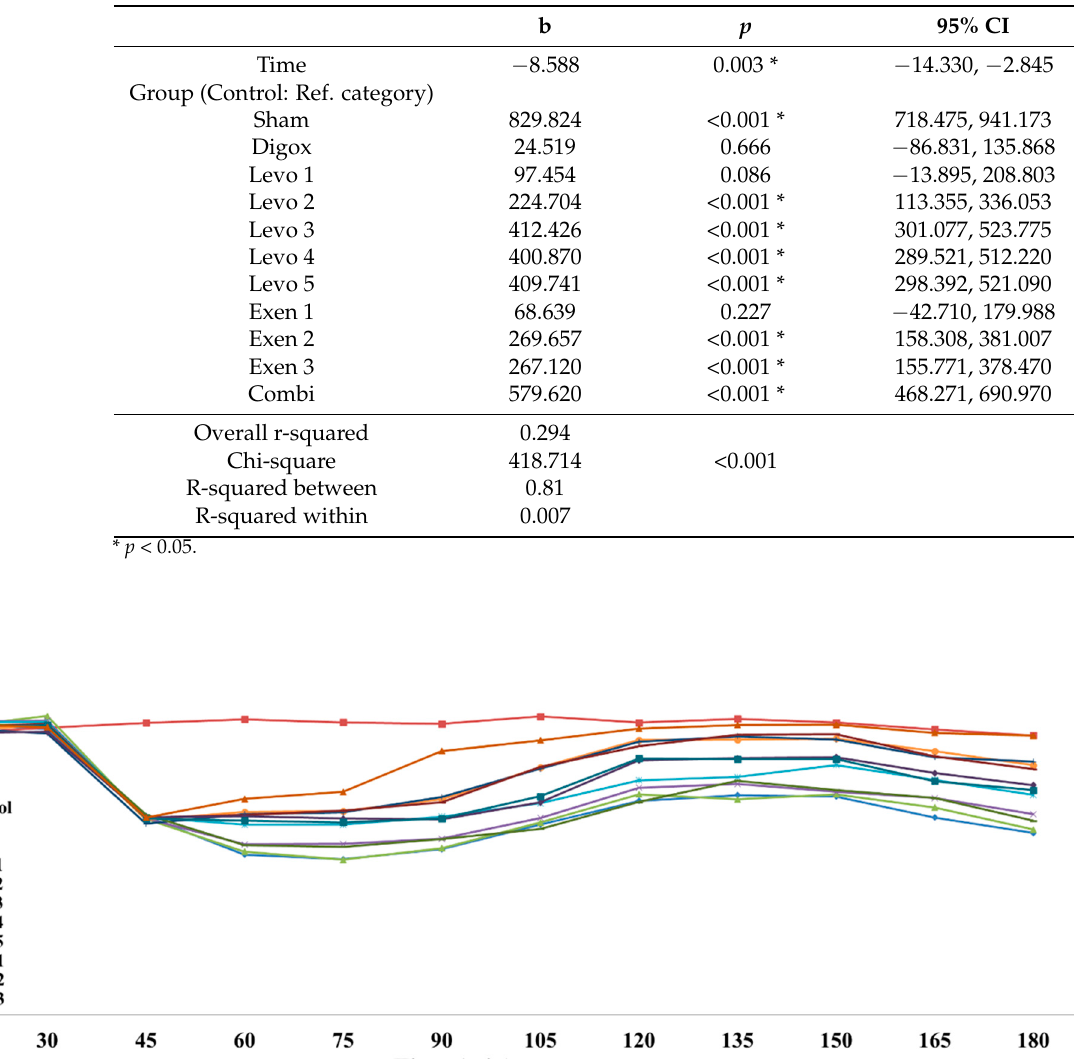
Table 7. Longitudinal analysis for − dP/dt for all groups.